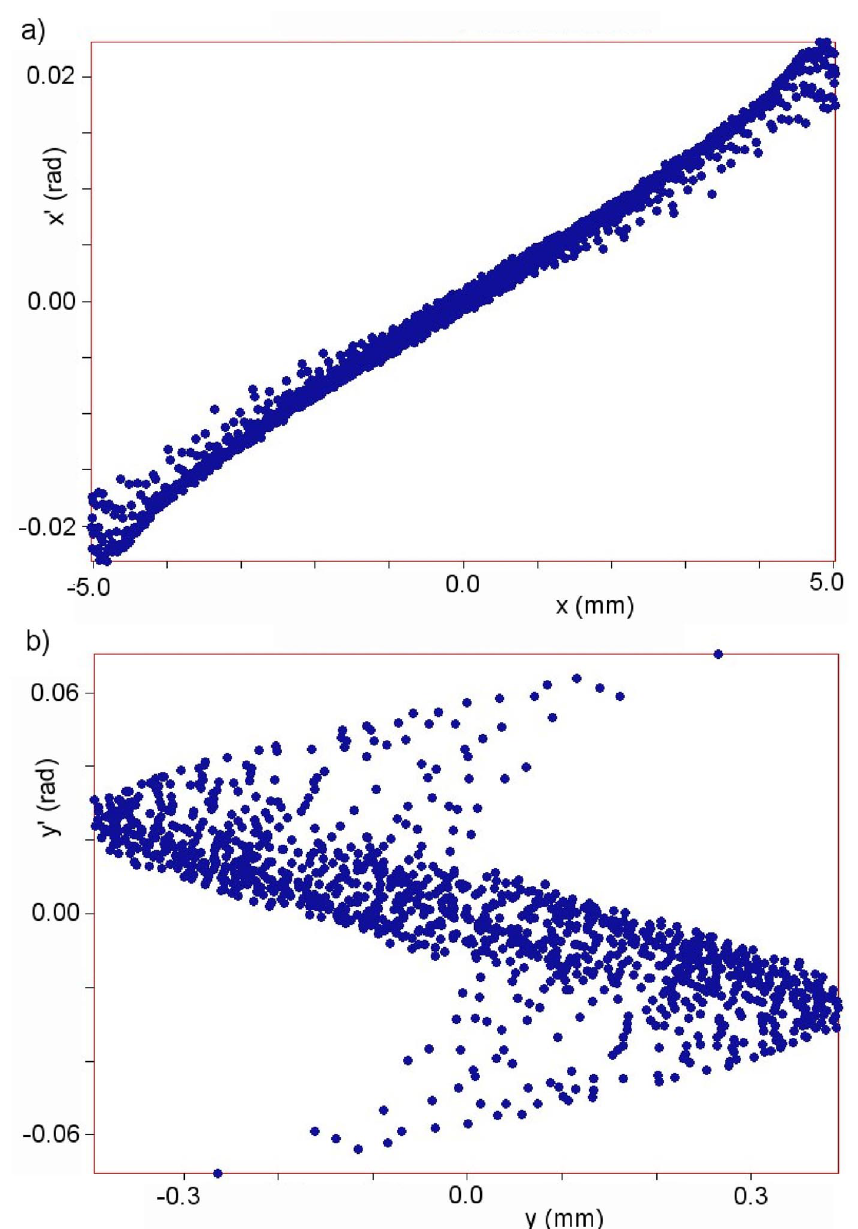
FIG. 8. (Color) Phase space distributions at the optimal focus. (a) Horizontal, x - x 0 . (b) Vertical, y - y 0